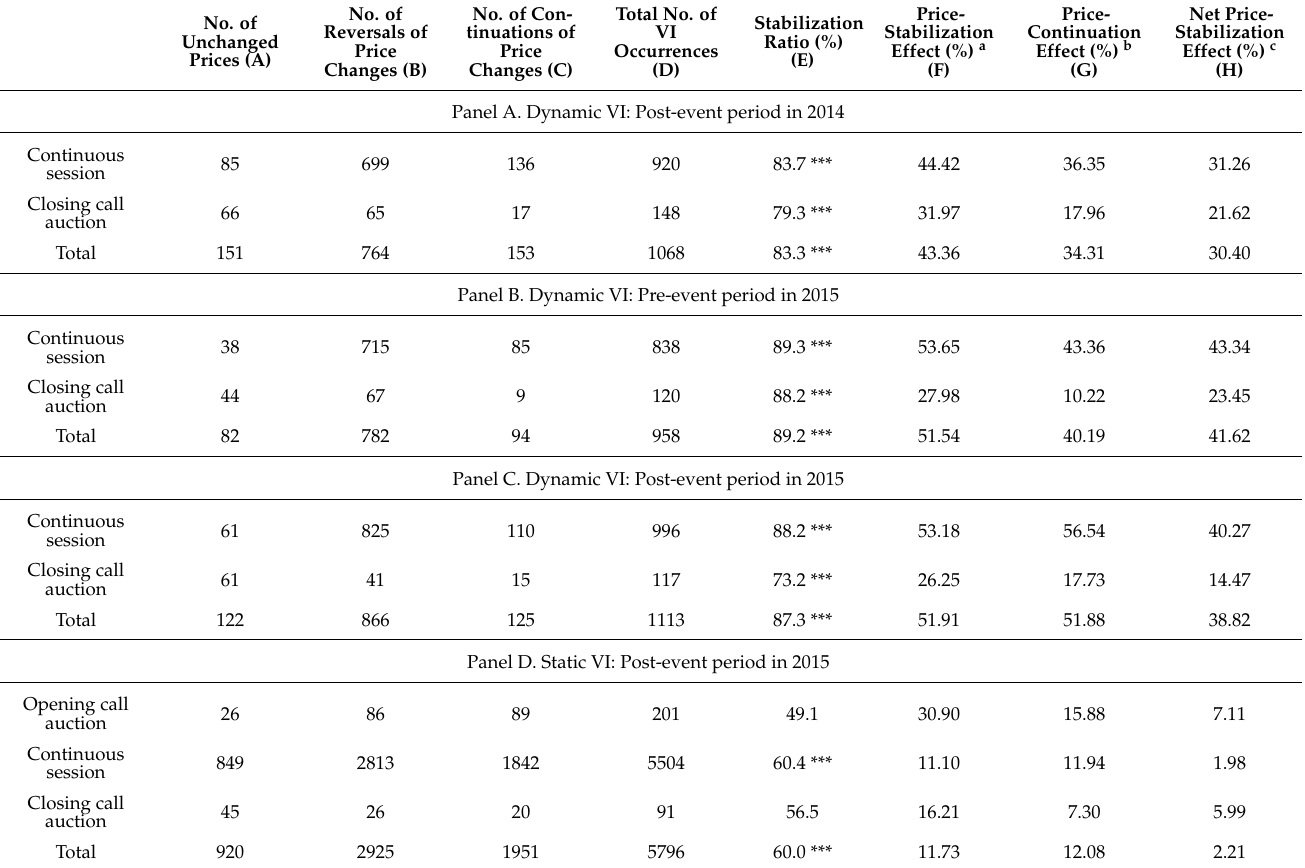
Table 3. Price-stabilization effect of VIs. This table describes the results of the binomial distribution analysis to evaluate the price-stabilization effect of VIs. Panels A to C present the results of dynamic VI during the post-event period in 2014, pre-event period in 2015, and post-event period in 2015, respectively, while Panel D presents the results of static VI during the post-event period in 2015. a denotes a percentage measure of reversals of price changes, and b denotes a percentage measure of continuations of price changes; both a and b are calculated by averaging|(call auction price − potential execution price) × 100/(potential execution price − last execution or last call auction price)|over the set of reversals and continuations, respectively. c denotes a percentage measure of net price stabilization, which is calculated by averaging − (call auction price − potential execution price) × 100/(potential execution price − last execution or last call auction price) over the combined set of reversals and continuations. *** denotes 1% statistical significance under the hypothesis that the probabilities of reversals and continuations of price changes are